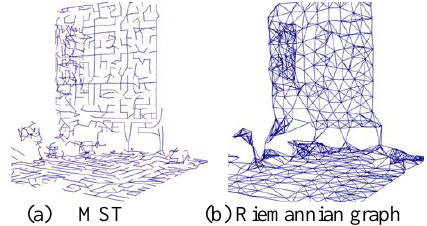
Figure 5. The construction of the voxel-based